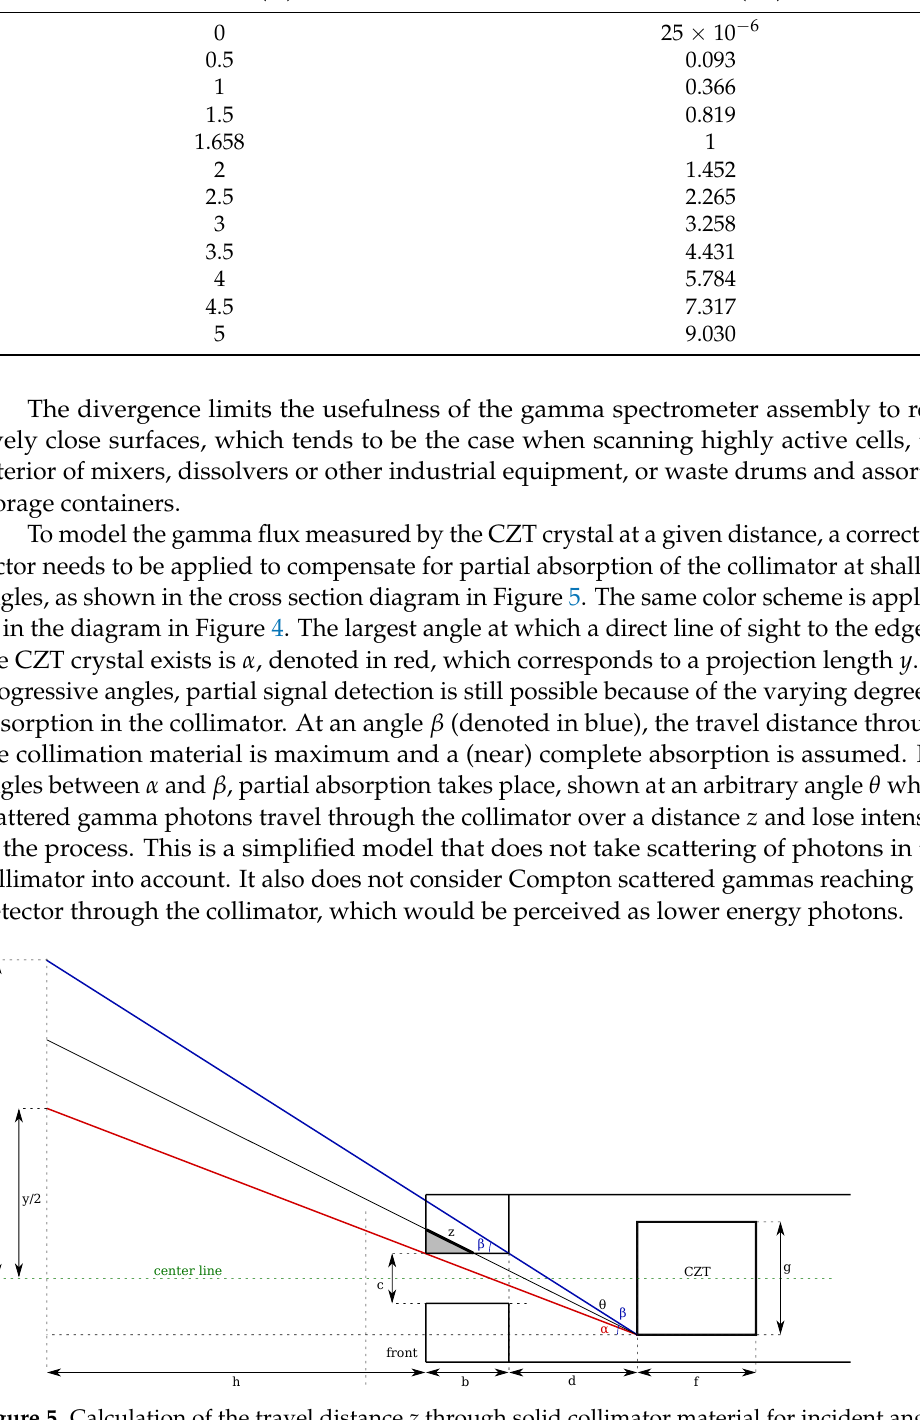
Figure 5. Calculation of the travel distance z through solid collimator material for incident angles larger than a direct projection through the collimator aperture allows. Colors are matched with Figure